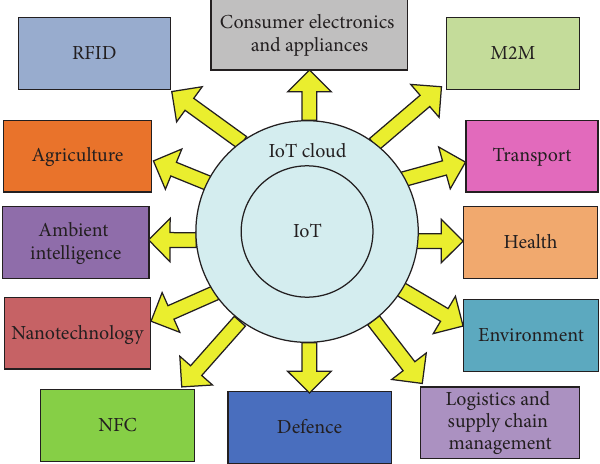
Figure 1: IoT cloud based